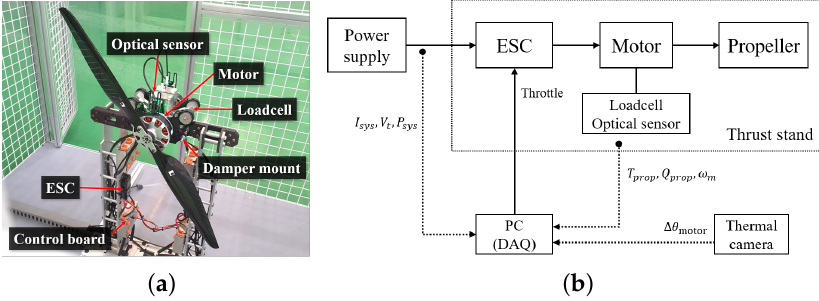
Figure 16. Configuration of the thrust stand: ( a ) RCbenchmark Series 1780. ( b ) DAQ structure diagram.